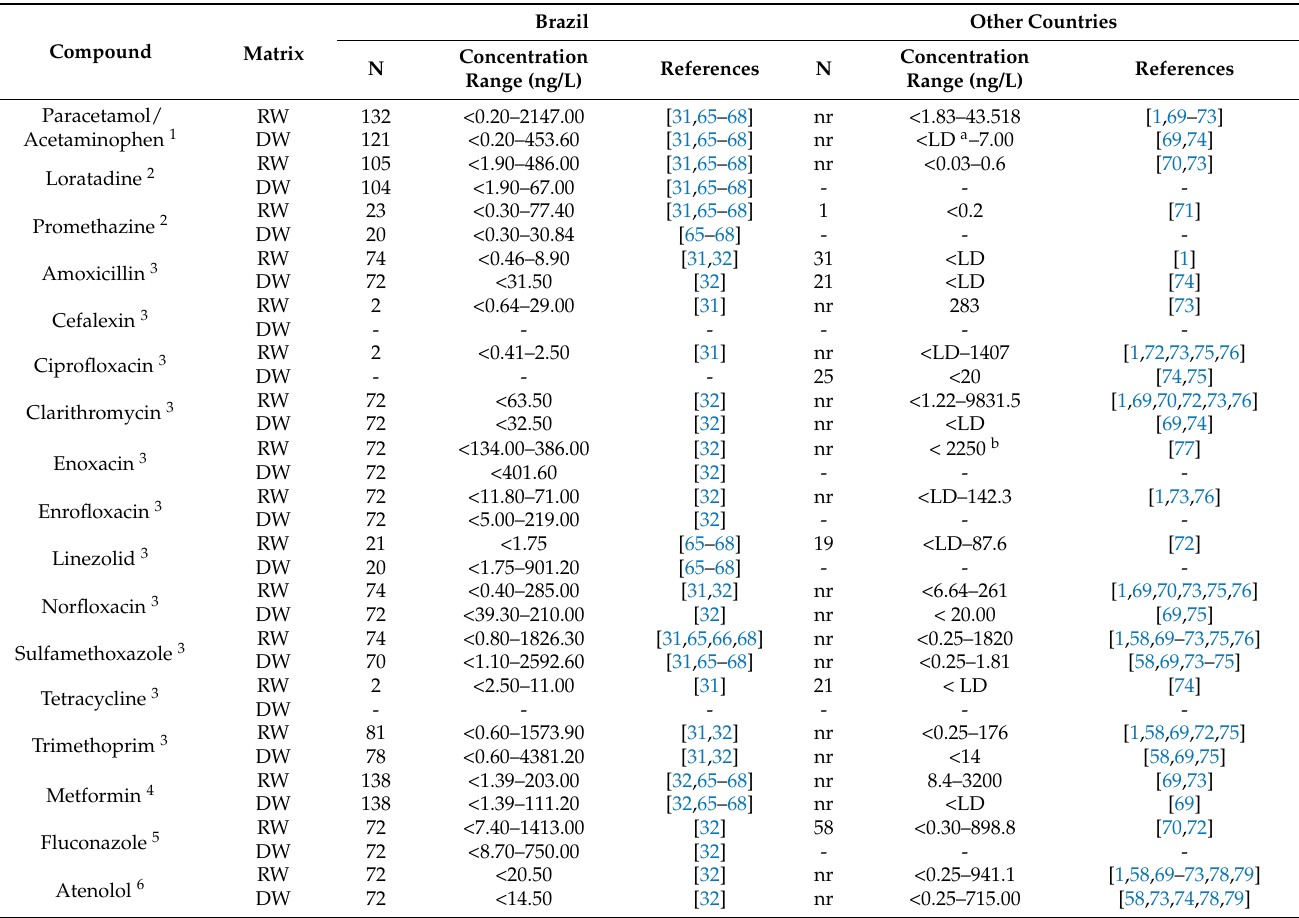
Table 1. Occurrence of pharmaceuticals and endocrine disrupting compounds (P&EDC) in Brazilian and foreign water ( . . . ). Brazil Other Countries Compound Matrix Concentration N Range